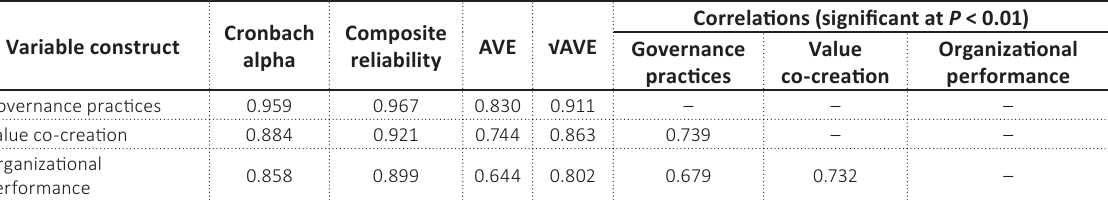
Table 3. Reliability, validity, and correlation